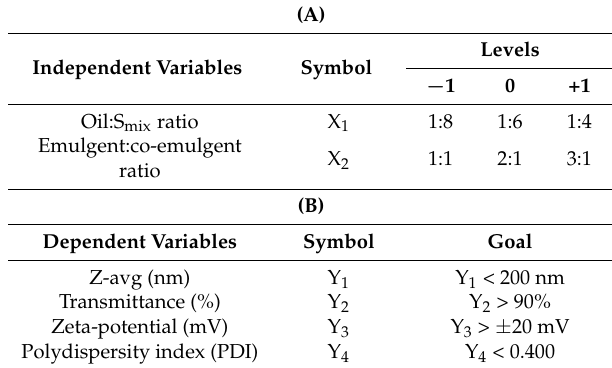
Table 1. Independent variables and their levels ( A ) and dependent variables with goals ( B ) used in face-centered experimental design.